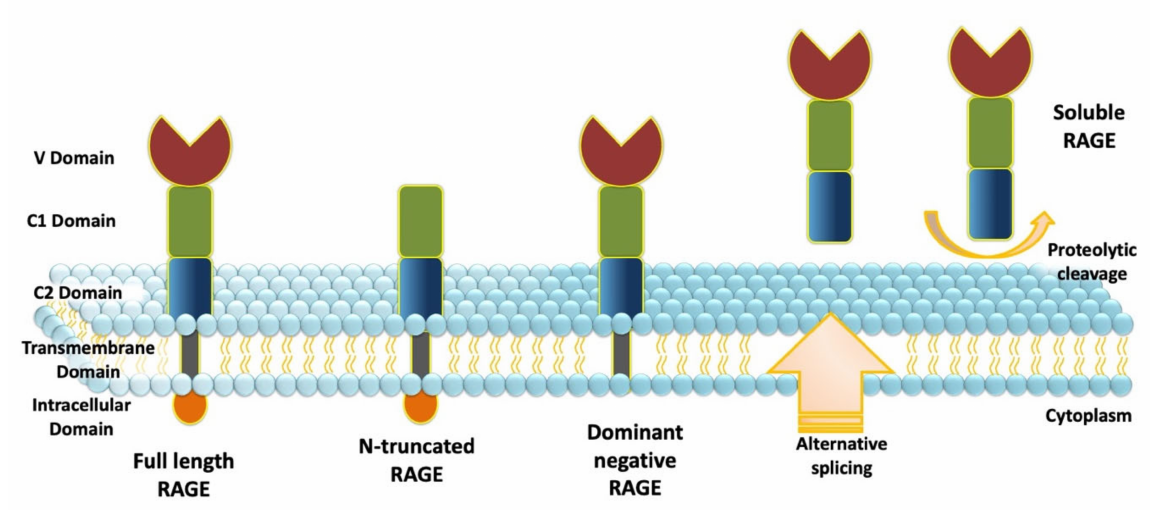
Figure 2. RAGE structure and isoforms. Full-length RAGE consists of three regions: an extracellular part itself divided into a variable-like (V), two constant-like Ig (C1 and C2) domains, a transmembrane domain, and a cytoplasmic domain. The soluble form of RAGE (sRAGE) contains the extracellular region but lacks both the transmembrane and cytoplasmic domains. The dominant negative isoform lacks the cytoplasmic domain, while N-truncated RAGE is deficient in the N-terminal V-like